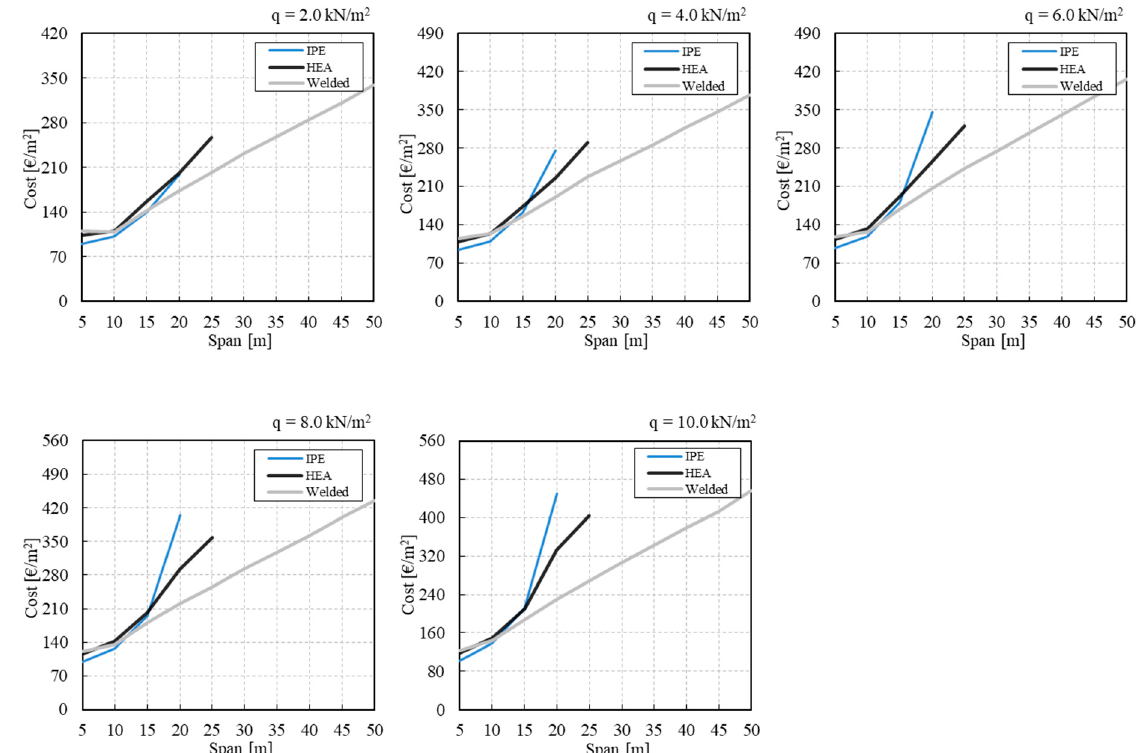
Figure 8. Comparative diagrams of the optimal energy life-cycle costs for the energy inefficient case (ELCC EIC) of the CFS structures with welded and standard IPE and HEA sections.